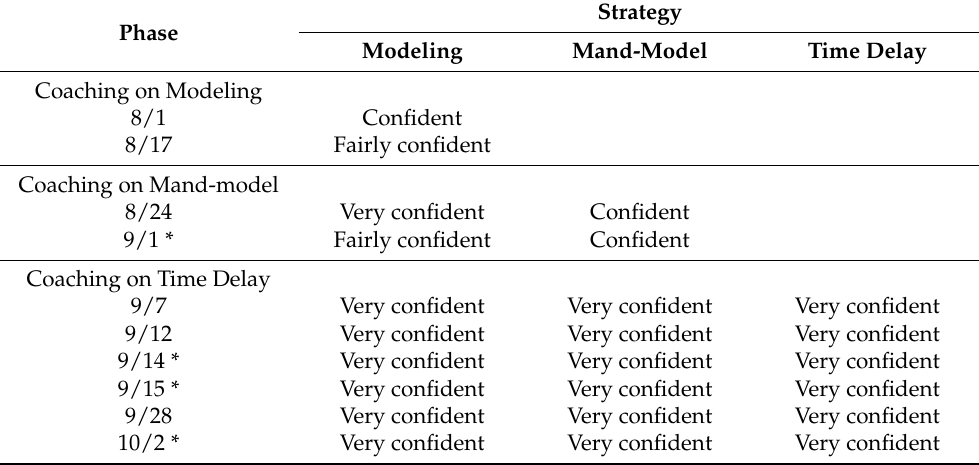
Table 3. Mediha’s Self-reported Confidence Ratings During